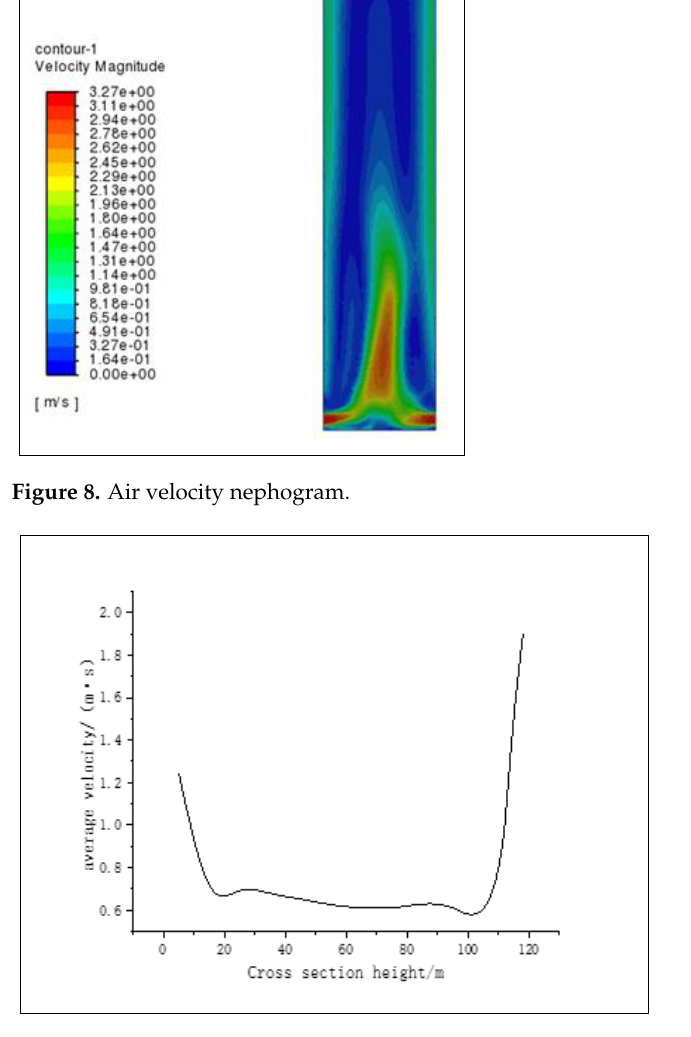
Figure 8. Air velocity nephogram.